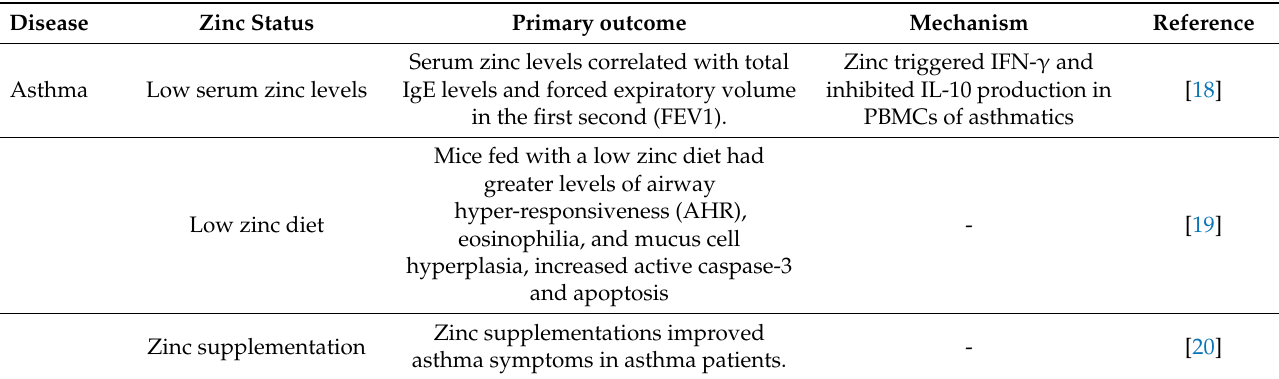
Figure 1. Role of zinc dysregulation in lung disease. Table 1. Role of zinc and zinc-regulatory molecules in lung